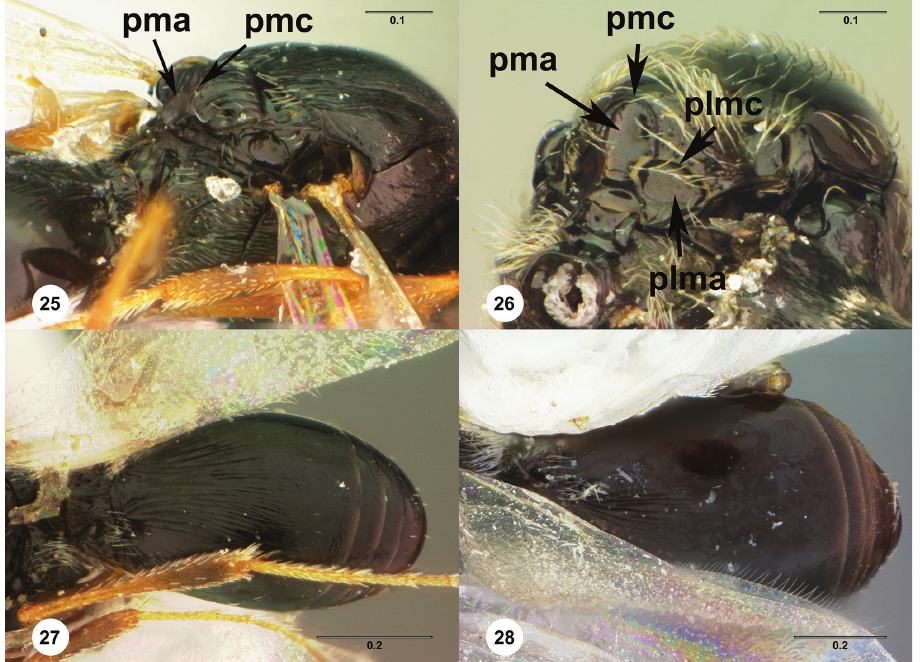
Figures 25–28. 43 25 Platygaster striativentris (Buhl), mesosoma, posterolateral view, male paratype (US­ NMENT00979421) 26 Platygaster sp., mesosoma, posterolateral view, male (USNMENT00877259) 27 Platygaster striativentris (Buhl), metasoma, dorsolateral view, male holotype (BLGA 0001) 28 Plat- ygaster haloxylonomyiae Kozlov, metasoma, dorsolateral view, male paratype (USNMENT00872138). Scale bars in